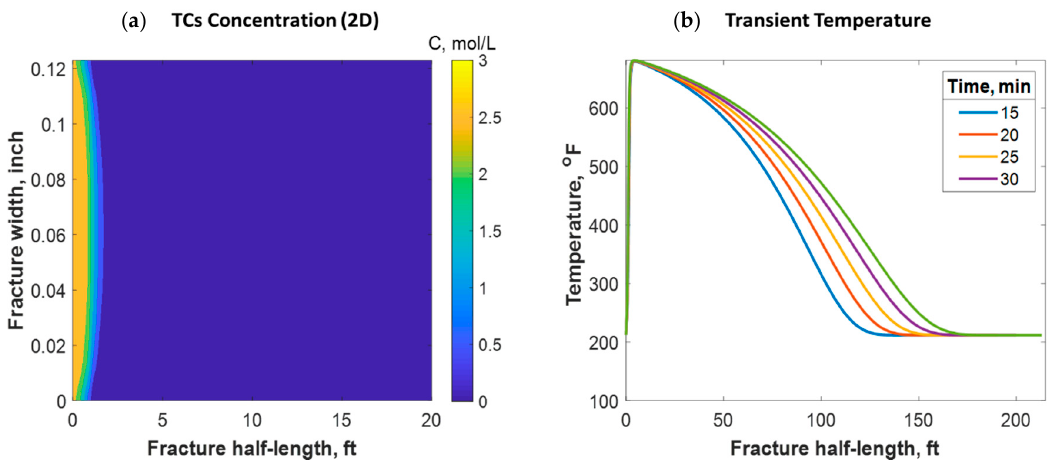
Figure 12. ( a ) 2-D TC concentration profile at the final injection time when the fluids were injected at 212 °F; ( b ) temperature profiles along the fracture at different times.